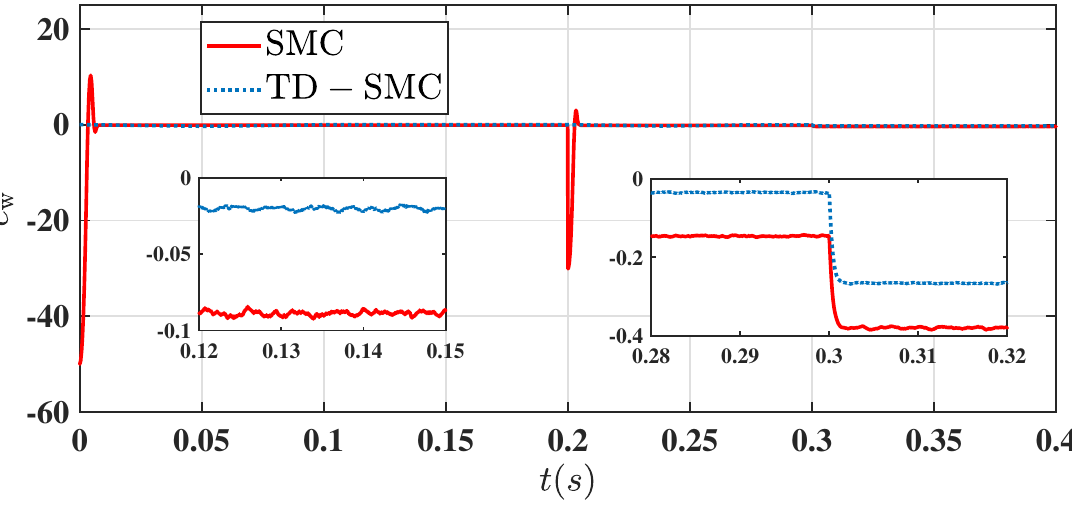
Figure 7. The characteristic curves of the regulation